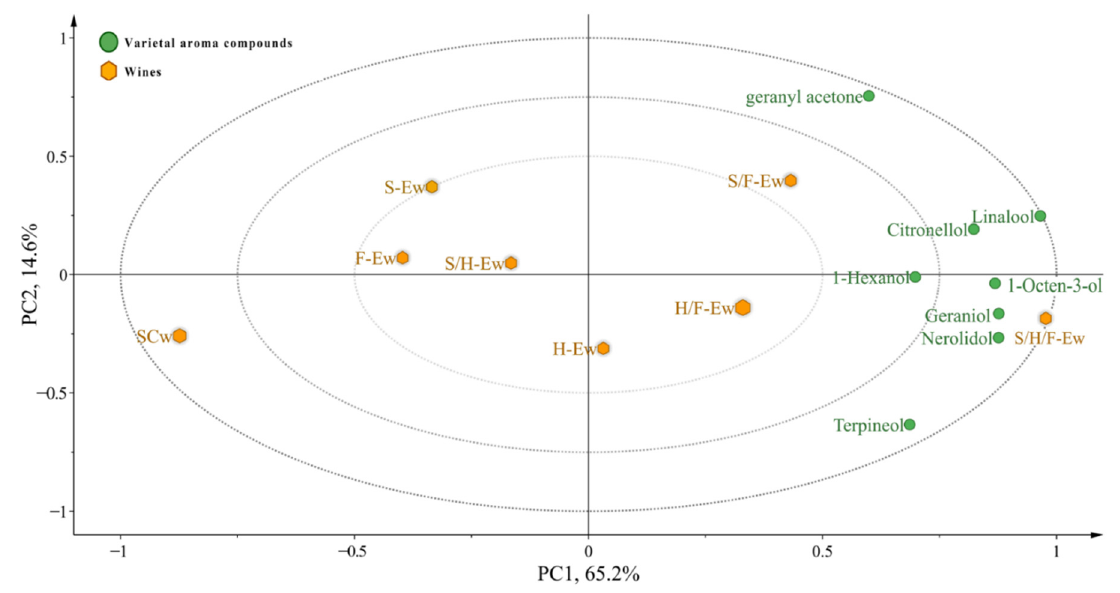
Figure 2. PCA of varietal aroma compounds from